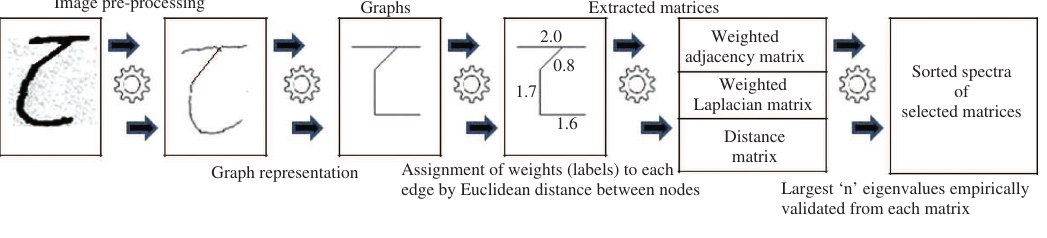
Figure 3: Process of Extraction of Sorted